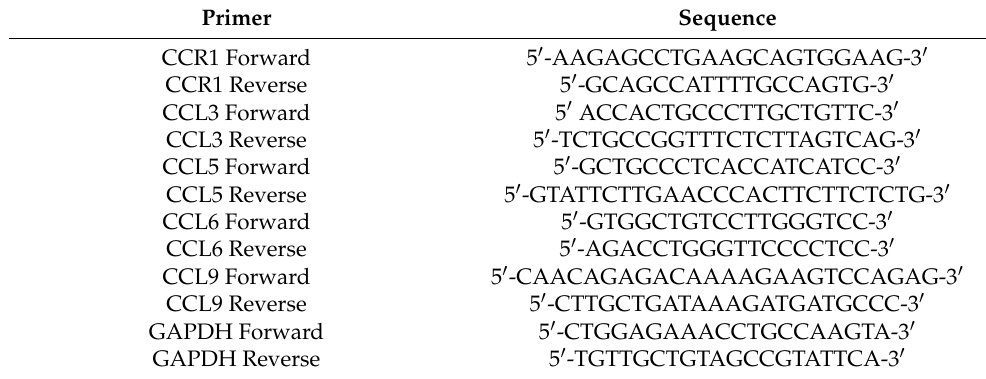
Table 1. Primers used in Quantitative RT PCR